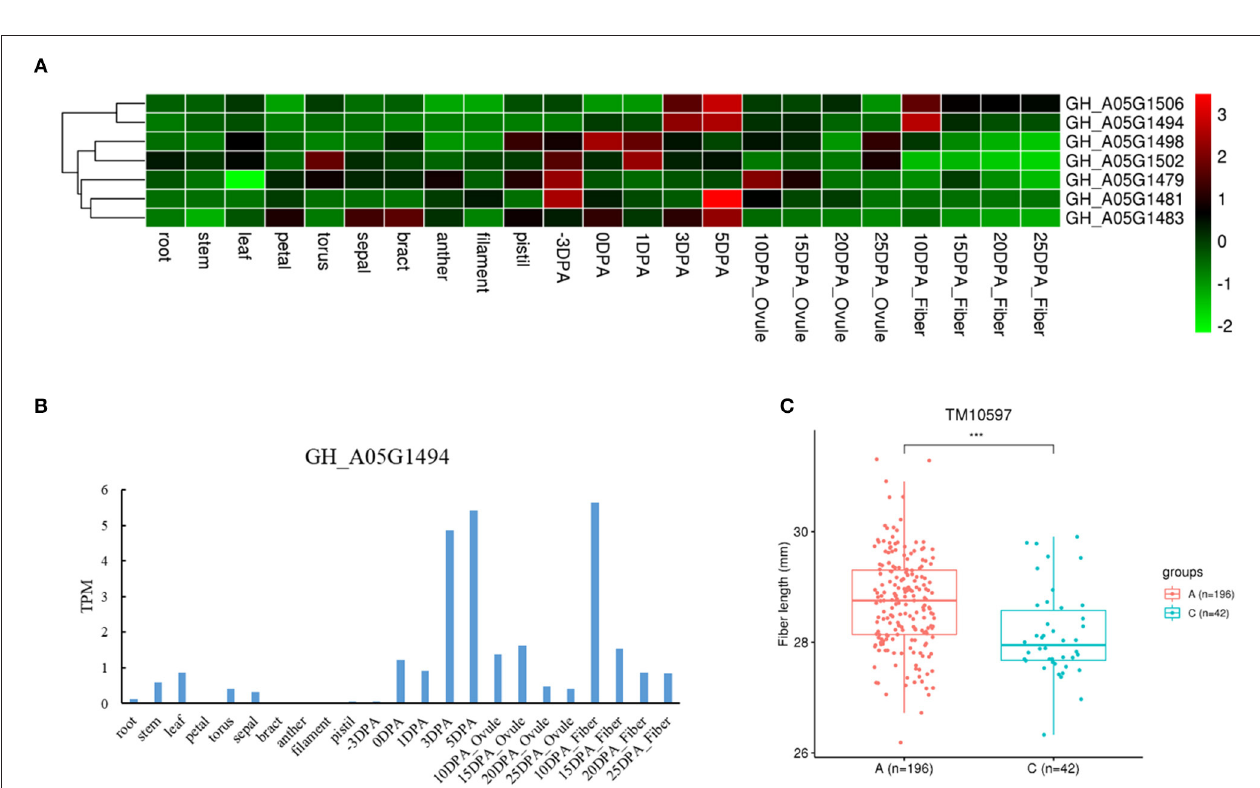
FIGURE 4 | Quantitative trait loci (QTLs) and candidate genes located on qtl11 on chromosome A05. (A) Expression heatmap of candidate genes in the qtl11. (B) The expression patterns of the GH_A05G1494 in different tissues. (C) Boxplots for the phenotypic values of quantitative trait nucleotide (QTN) in UTR region of the GH_A05G1494 . *** P < 0.001.